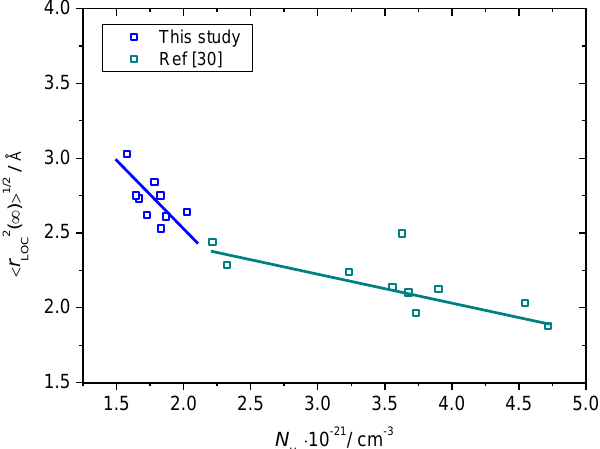
Figure 8. Spatial extent of localized motions of polarons, < r LOC2 ( )> 1/2 , as a function of the number density of polarons for x B 2 O 3 –(100 − x )[40Fe 2 O 3 –60P 2 O 5 ] glasses from this study and HfO 2 -Fe 2 O 3 -P 2 O 5 , CeO 2 -Fe 2 O 3 -P 2 O 5 and HfO 2 -Fe 2 O 3 -B 2 O 3 -P 2 O 5 glasses from Ref. [30]. Lines are drawn as guides for the eye.